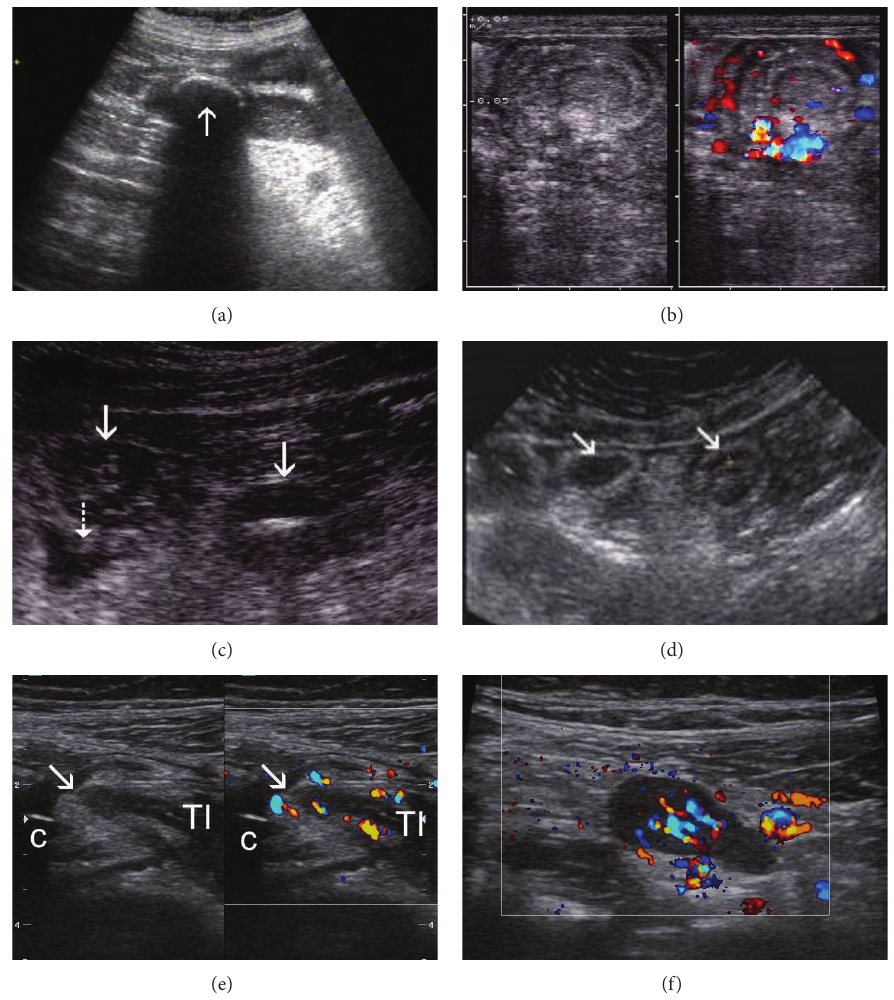
Figure 7: (a) Gallstone ileus—oval reflex with acoustic shadow in dilated jejunum. Standard probe. (b) Intussusception of jejunum. High resolution probe. (c) Spontaneous jejunal haematoma—transverse view of thickened hypoechogenic jejunal loops with absence of vascularization (in CFD)—arrows. Dotted arrow point to small peritoneal fluid. Patient in the hypocoagulation state, high resolution probe. (d) Spontaneous bowel haematoma transverse section of thickened jejunal loops with preserved stratification and narrowed lumen in a patient with hemophilia—(arrows)— standard probe . (e) longitudinal view of thickened terminal ileum (TI) and Bauhin’s valve (arrow) with hypervascularisation of bowel wall (Yersinia ileocolitis)— high resolution probe . (f) Mesenterial lymphadenitis in the right iliac fossa in the same case— high resolution probe